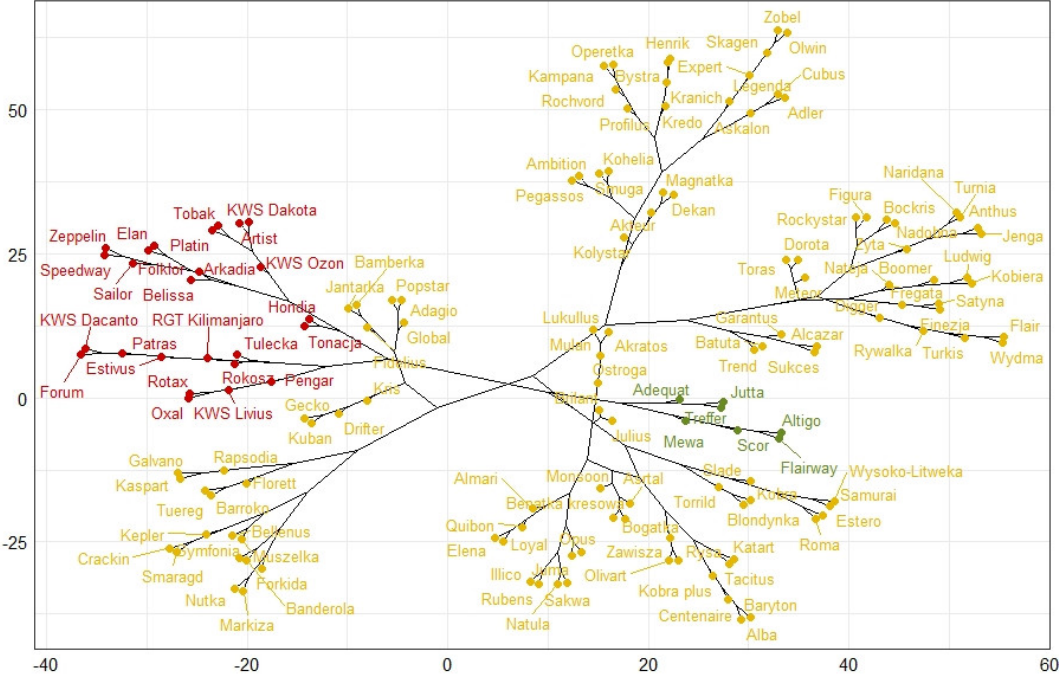
Figure 4. Distribution of the studied genotypes of plants using the method of hierarchical K−means in laboratory conditions with the inoculation of R. solani (clustering in the form of a phylogenetic tree). The colors correspond to the assigned clusters according to the resistance type; red−susceptible, yellow−less susceptible, green−least susceptible.